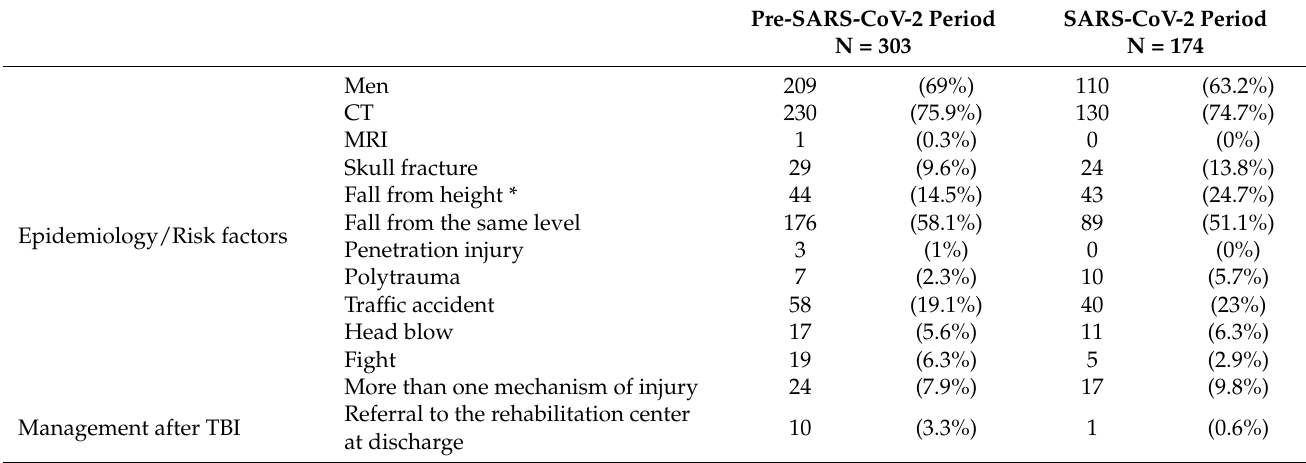
Table 1. Epidemiology and management of patients with mild TBI.